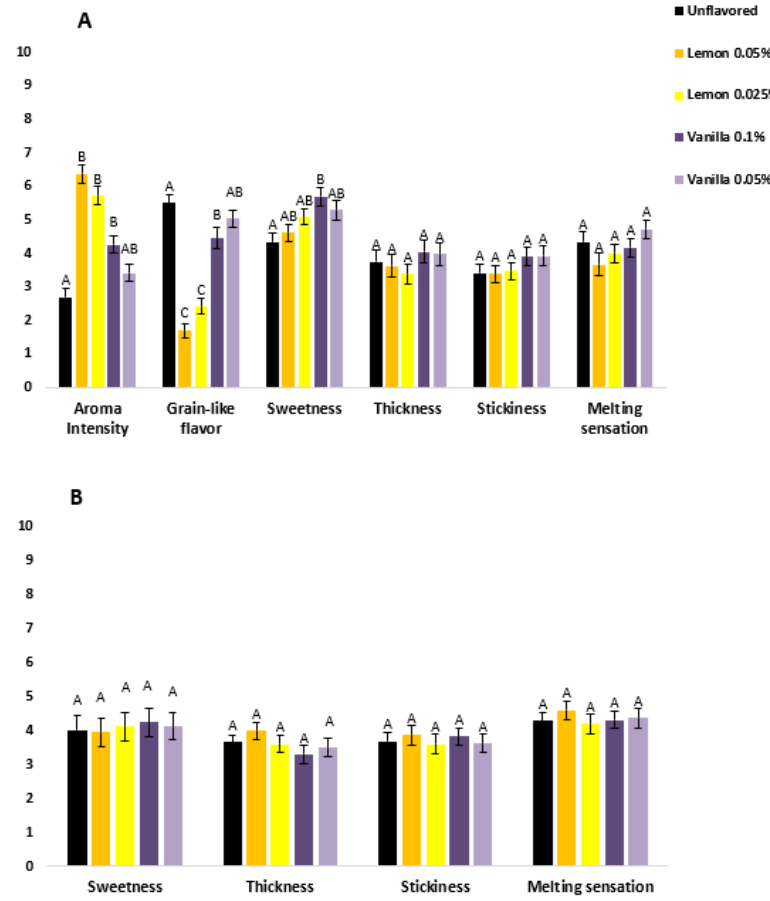
Figure 1. Mean ratings and the standard error of the mean (SEM) ( n = 4 × 10) of odor, flavor, and mouthfeel properties without a nose clip ( A ) and with a nose clip ( B ) in different samples, i.e., U-0, L-2, L-1, V-2, and V-1, referring to unflavored, Lemon 0.05%, Lemon 0.025%, Vanilla 0.1%, and Vanilla 0.05%, respectively. Letters indicate a statistically significant difference between the samples: p < 0.05 by Tukey HSD test.